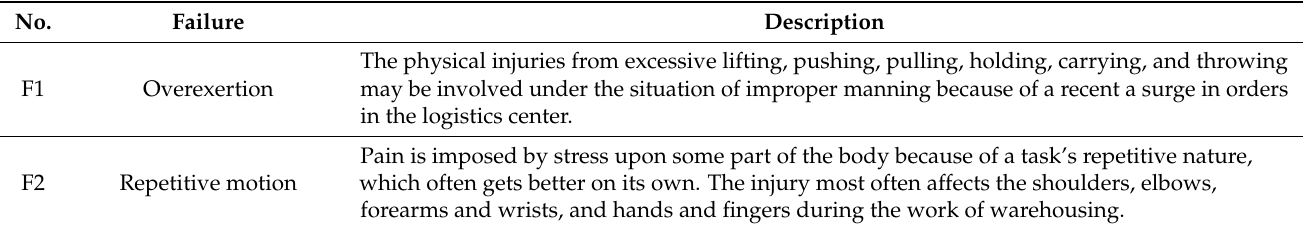
Table 4. Risks of picking and material-handling accidents by relevant literature and